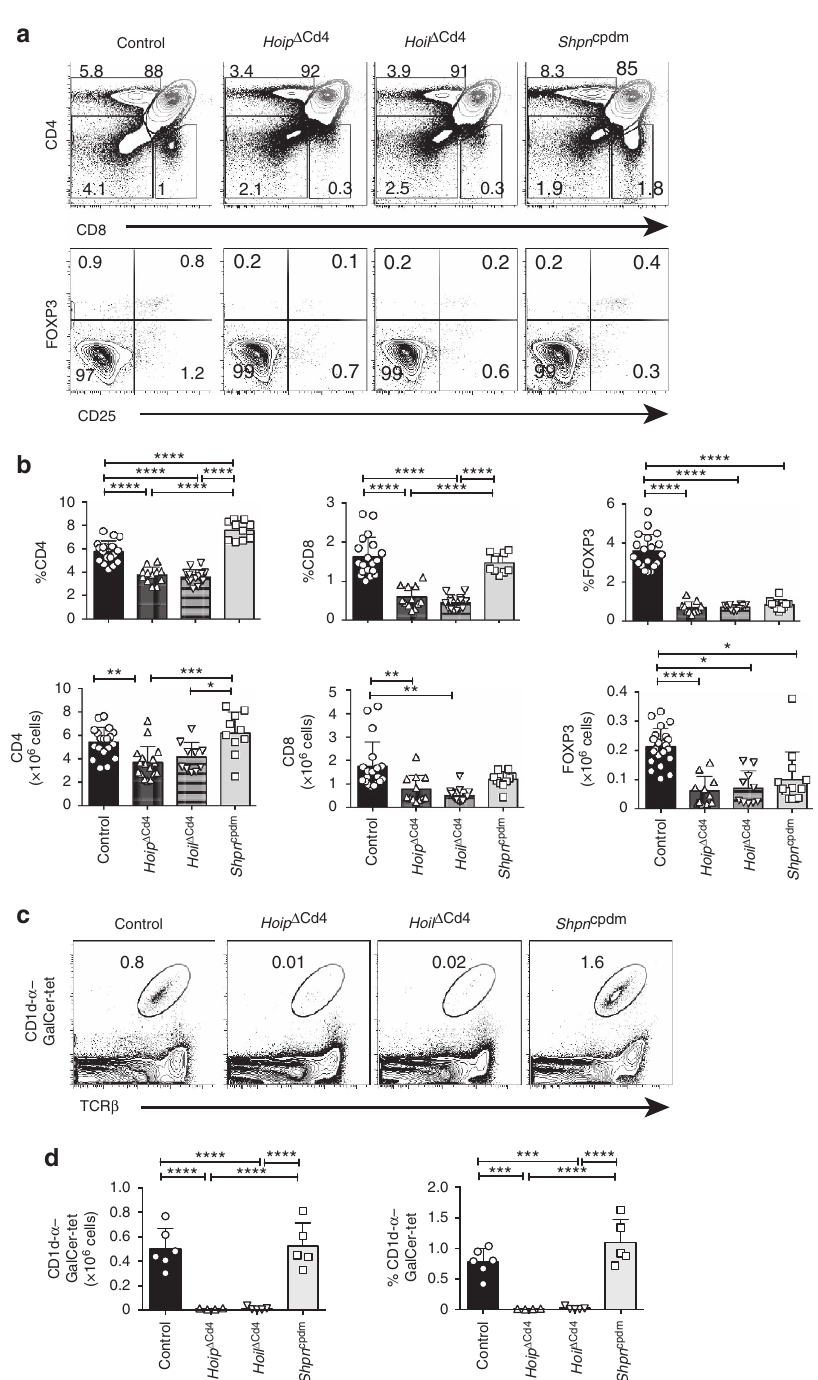
Figure 2 | Thymic T-cell differentiation in LUBAC-deficient mice. ( a ) Surface staining of CD4 and CD8 (upper panels), and FOXP3 and CD25 (lower panels) on thymocytes from 7- to 15-week-old control, Hoip D Cd4 , Hoil D Cd4 and Sharpin cpdm mice. ( b ) Quantification of total cell numbers and percentages of CD4 þ CD8 þ and FOXP3 þ thymocytes. ( c ) Flow cytometric analysis of thymic CD1d- a GalCer tetramer-positive NKT cells from 7- to 15-week-old control, Hoip D Cd4 , Hoil D Cd4 and Sharpin cpdm mice. ( d ) Total cell numbers and percentages of CD1d- a GalCer tetramer-positive NKTcells in the spleen. For b and d , each symbol represents an individual mouse; small horizontal lines indicate mean ± s.d.; * P o 0.05, ** P o 0.01, *** P o 0.005 and **** P o 0.001, respectively. One-way analysis of variance with a Tukey’s post-hoc test for multiple comparisons was used for statistical analysis. Shpn cpdm refers to Sharpin cpdm mice. Data are pooled from six independent experiments with two to six mice per group ( a , b ) or representative of two independent experiments with four to six mice per group ( c , d HOIP, early positive and negative selection events occur normally, CD62L high CCR7 þ / (cid:2) CD4SP (Fig. 3c,d and Supplementary but that SP thymocyte maturation is almost completely blocked. Positively selected thymocytes upregulate the chemokine receptor CCR7 and migrate into the medulla, where a second (Fig. 3b–e). These data establish that, in the absence of HOIL-1 or